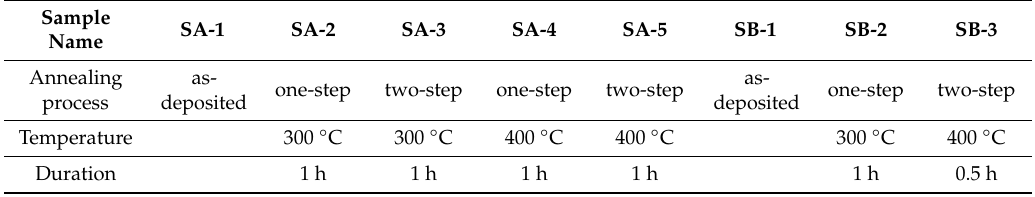
Table 2. Sample names and annealing conditions of the eight devices included in Figures 6 and 7.